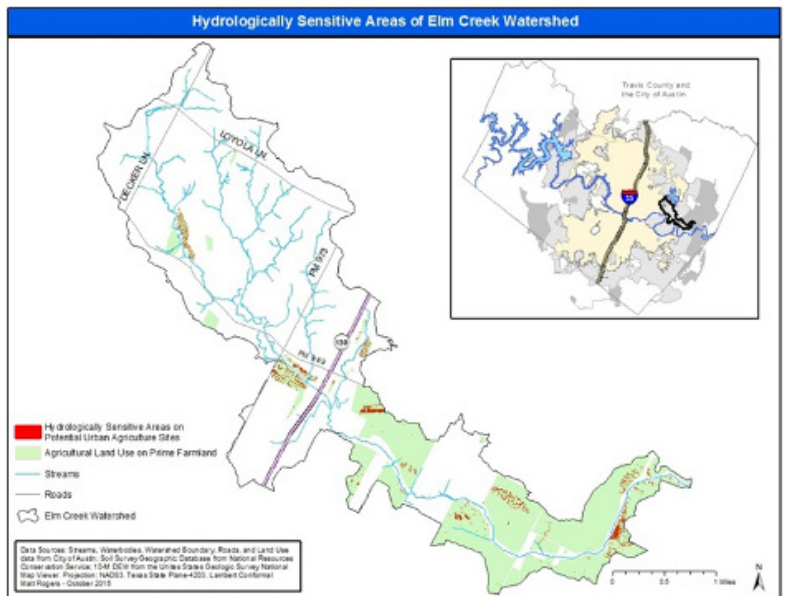
Figure 3. The spatial distribution of hydrologically sensitive areas (HSAs) in Elm Creek Watershed in Austin, TX. HSAs in Elm Creek watershed have topographic index (TI) values 1.5 standard deviations above the mean or greater than 14. These particular HSAs are on potential urban agriculture sites as determined by their location on land deemed agricultural by the City of Austin and considered prime farmland by the National Resources Conservation Service (NRCS). Table 2. Potential urban agriculture land totals in Elm Creek and in Decker Creek watersheds: agricultural land use on prime farmland, HSAs on prime farmland with agricultural land use, and HSAs on prime farmland with agricultural land use without Critical Water Quality Zone (CWQZ)